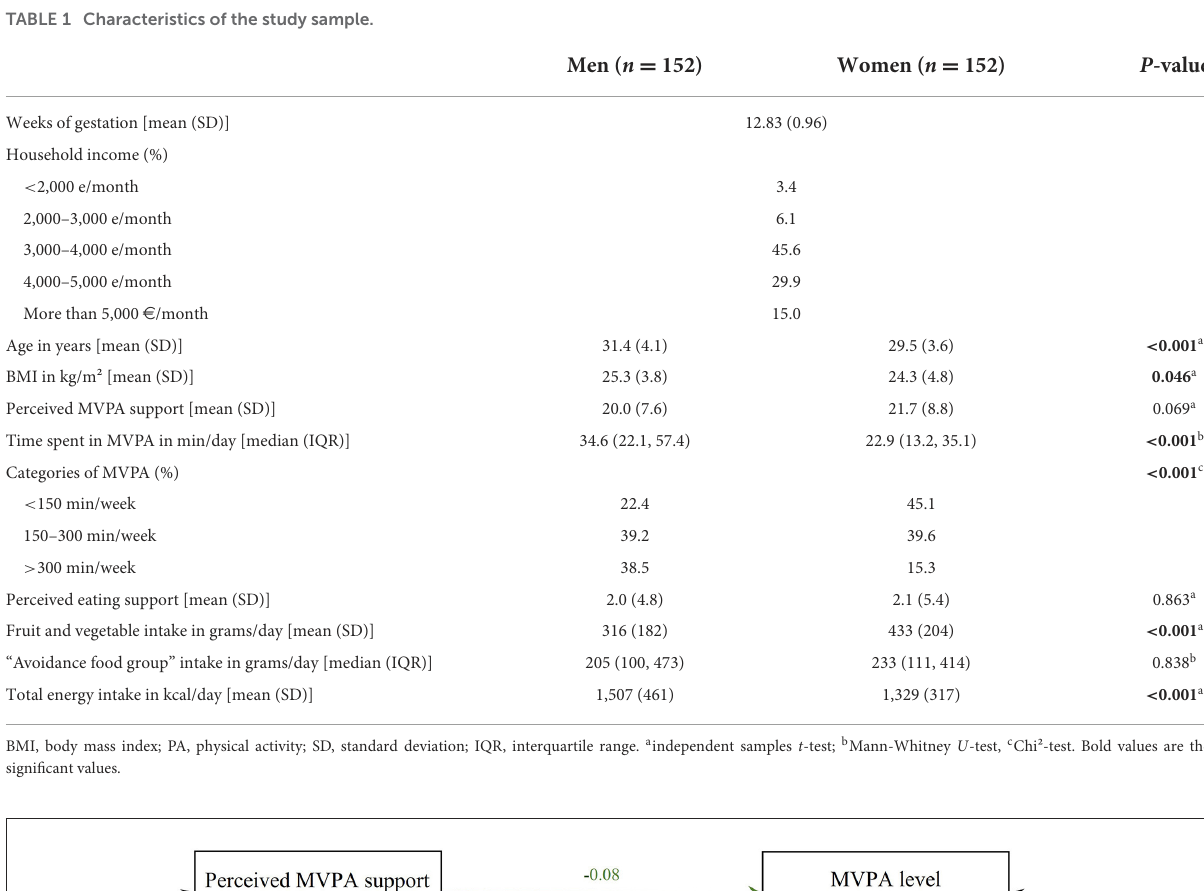
TABLE 1 Characteristics of the study sample.